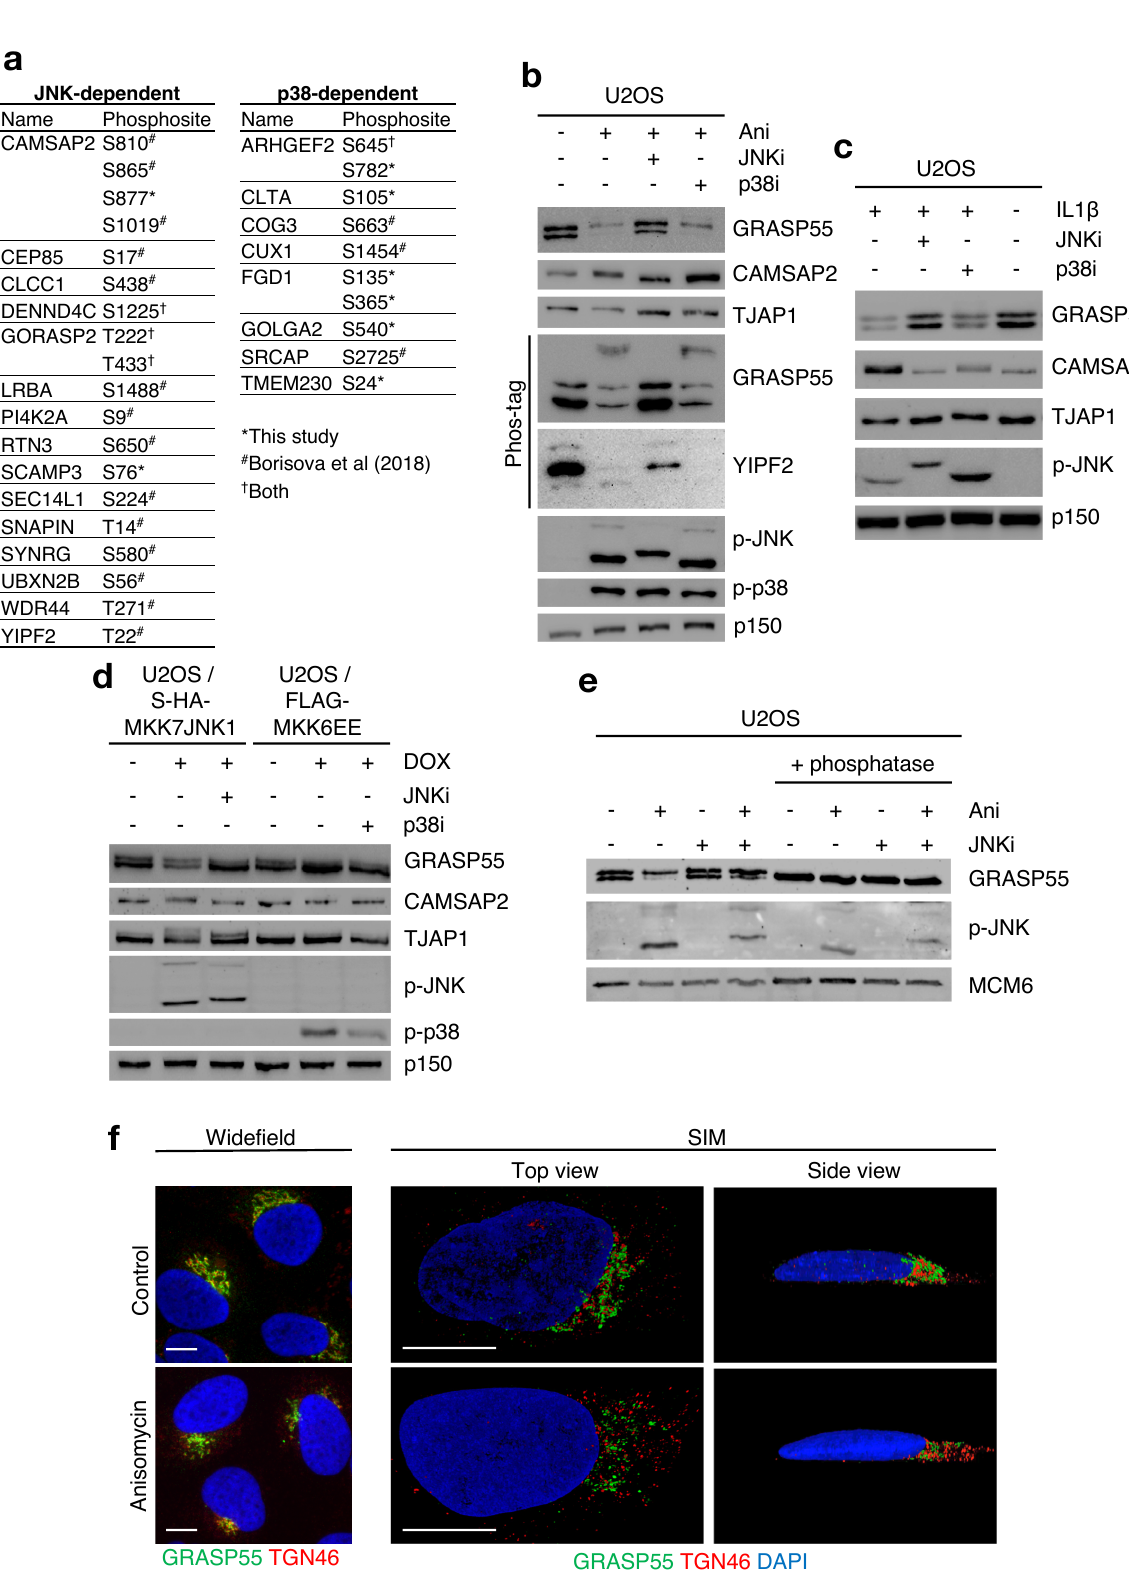
Figure 4. JNK phosphorylation targets in the Golgi apparatus. ( a ). JNK- and p38-dependent phosphorylation sites on Golgi apparatus-resident proteins or Golgi trafficking proteins extracted from Figure 1c, Table S1 and [11]. ( b ). U2OS cells were pre-treated with JNK and p38 inhibitors (JNKi, p38i, 0.5 h) and treated with anisomycin (Ani, 1 h) as indicated. Lysates were separated by SDS-PAGE or phos-tag gel and analyzed by immunoblotting with the indicated